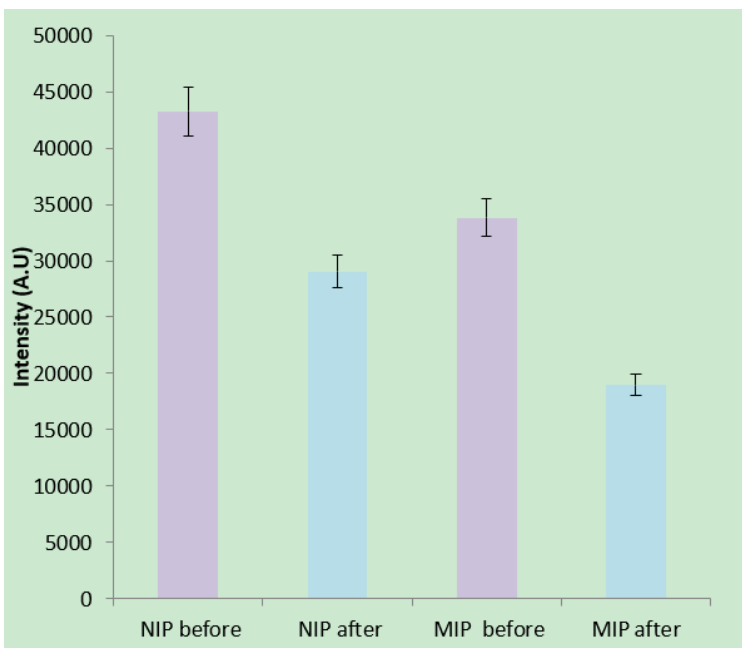
Figure 9. Fluorescence quenching of nanodiamond (peak around 700 nm) for molecularly imprinted and non-imprinted polymers before and after the addition of creatinine.